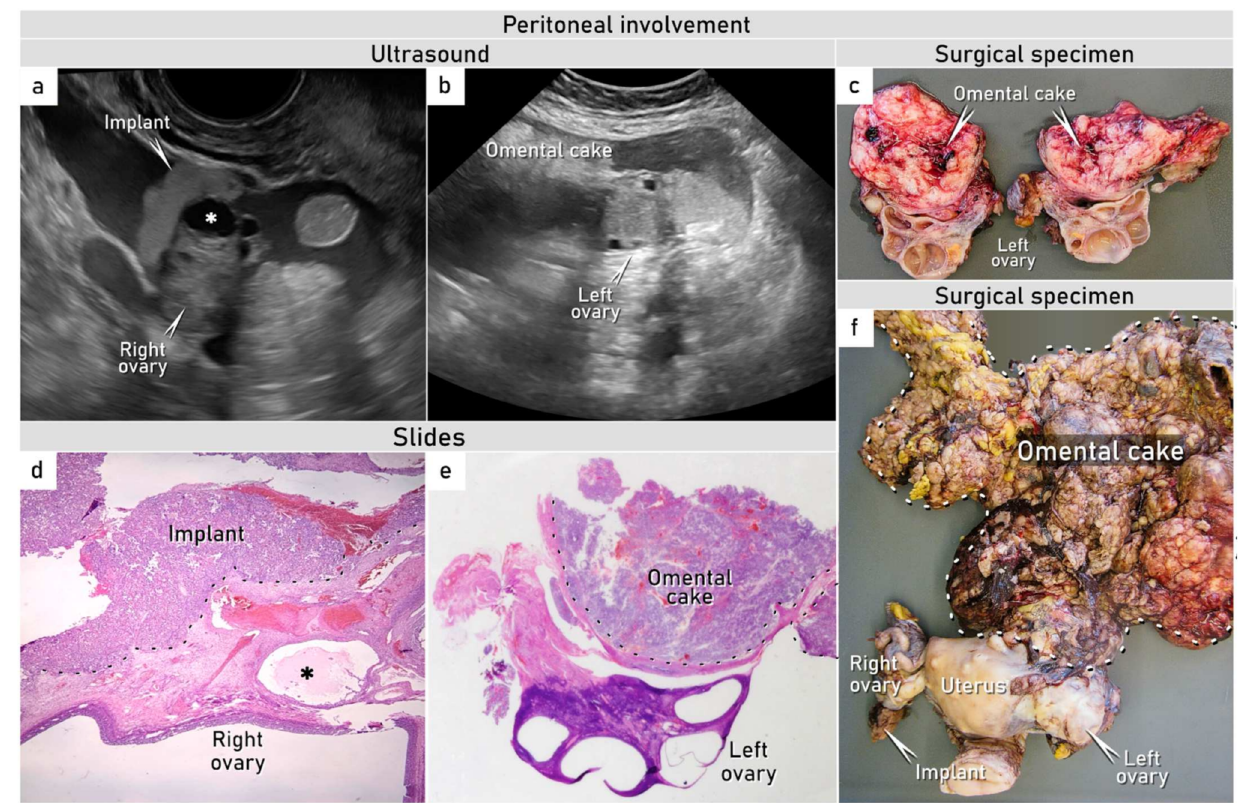
Figure 1. Peritoneal involvement. Ultrasound images in transverse plane demonstrating ( a ) peritoneal visceral implant on the right ovary and ( b ) omental infracolic cake extending on the visceral surface of the left ovary and uterine fundus. ( c ) Surgical specimen showing infracolic omentum densely adherent to the left ovary. ( d ) Microscopic specimen (H&E, 40 × ) showing tumor implant secondarily infiltrating the cortex of the right ovary; the dashed line shows the boundary between the superficial tumor implant and the ovarian cortex. ( e ) Omental cake is adherent to the surface of the left ovary on histotopogram without any neoplastic involvement of the ovary itself; the dashed line shows the boundary of the infracolic omental cake in adhesions to the left ovarian surface. ( f ) Surgical specimen of uterus and ovaries. See also Supplementary Video S1. * Follicular cyst found on the ultrasound examination ( a ) and in microscopic specimen ( d